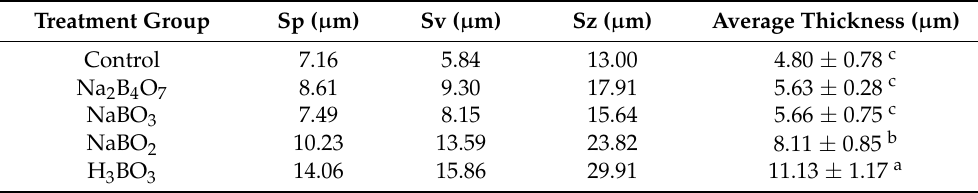
Table 1. The average thickness of the biofilms in the corresponding CLSM diagrams. Treatment Group